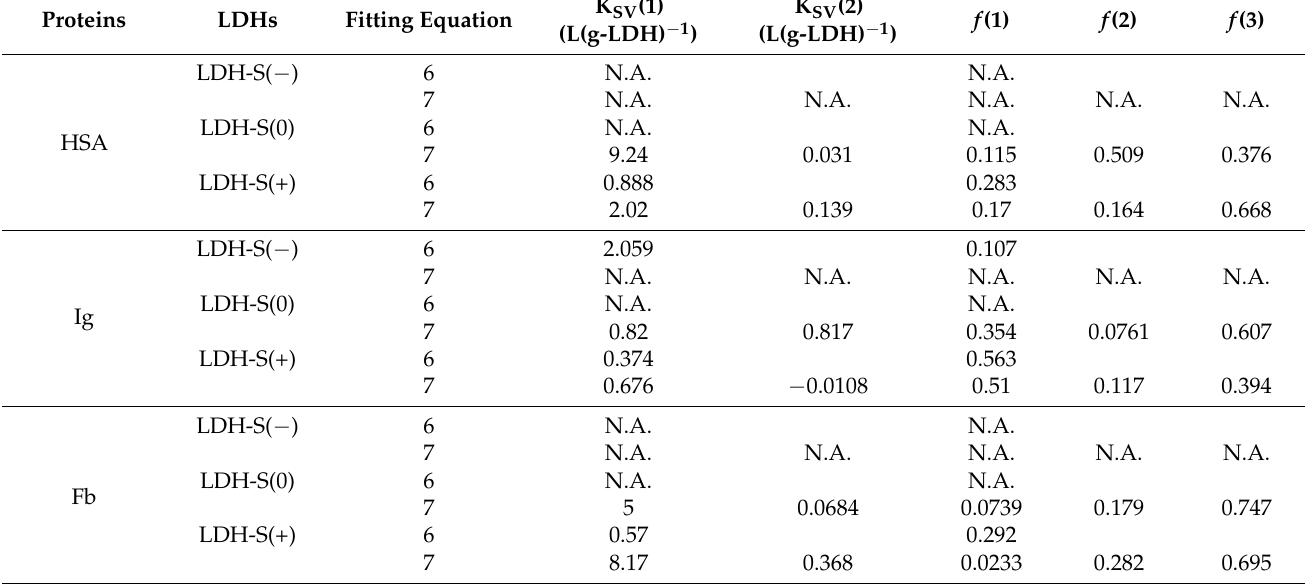
Figure 5. Schematic drawing of quenching of protein fluorescence by LDH with ( a ) stronger interaction with positively charged LDHs (LDH-S, LDH-M, LDH-L and LDH-S(+)) and ( b ) weaker interaction with LDH-S(0). Table 3. Fitting parameters obtained from modified Stern–Volmer plots (6) and Stern–Volmer plots for three types of fluorophore (7) by surface charge-controlled